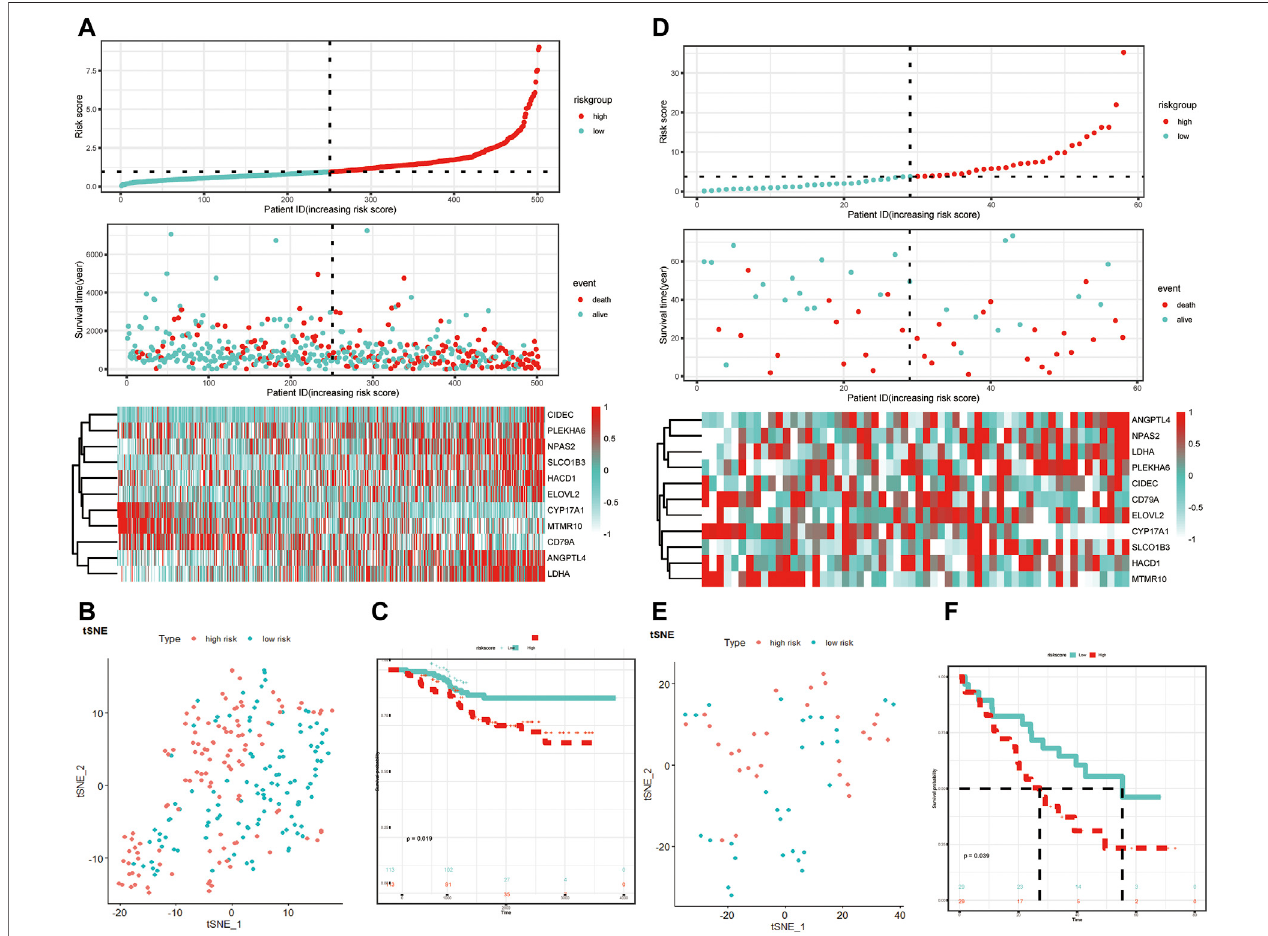
FIGURE 4 | Validation of the LRG-related prognostic model. (A,D) Heatmap of the 11-LRG-related gene expression pro fi les and the distribution of risk score and survival time/status for GSE31210 and GSE3141. (B,E) t-SNE and PCA plot of 11-LRG-related gene expression pro fi les for GSE31210 and GSE3141. (C,F) The Kaplan – Meier curve was plotted to estimate the overall survival probabilities of the low- and high-risk groups for GSE31210 and GSE3141. Diverse tumor immune microenvironment between high- and low-risk LUAD patients.